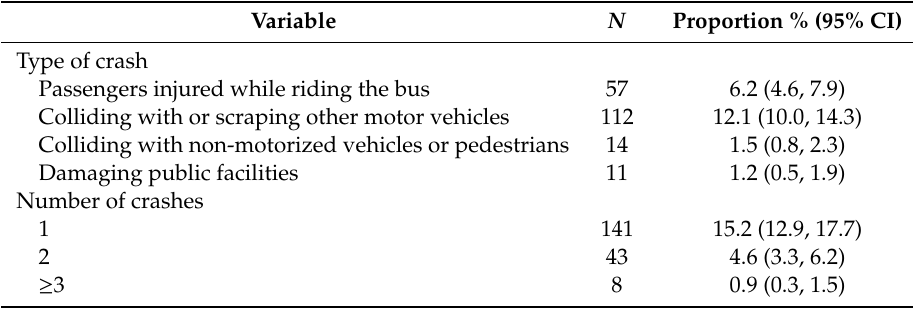
Table 2. Bus driver report of tra ffi c crashes in the past month.